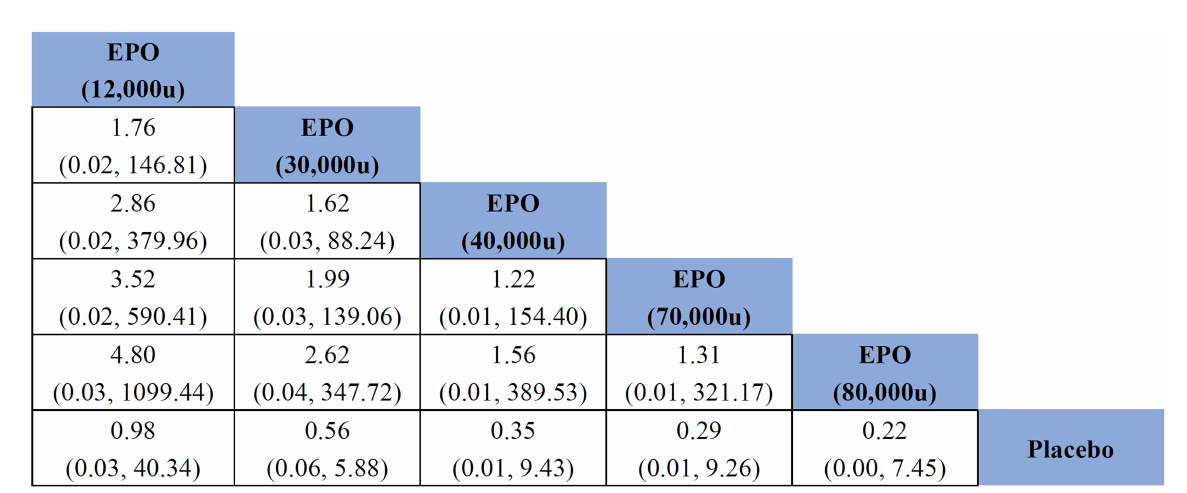
JY and SW: figure and table production. XL: designing of study, solving the problem, and reviewing the manuscript.